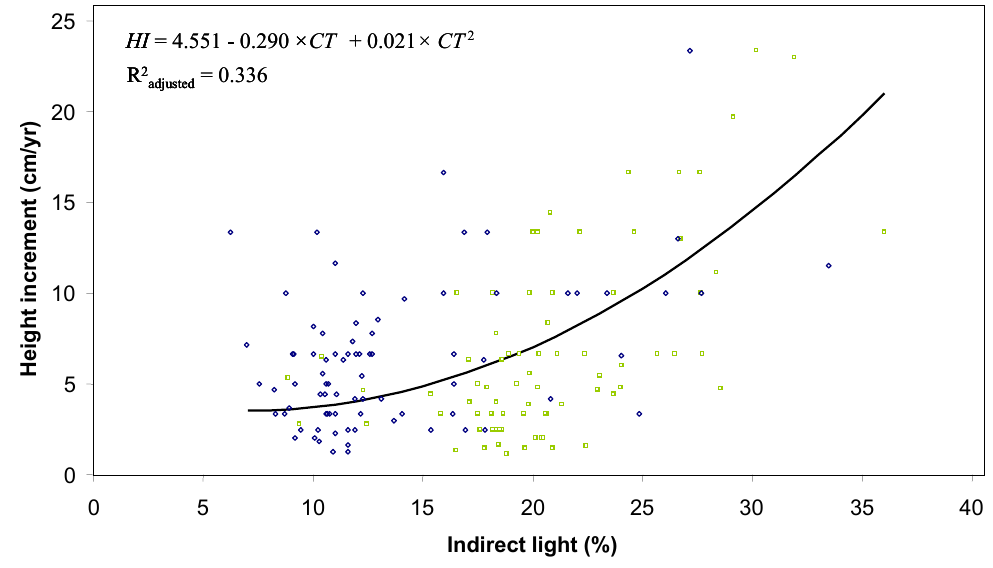
Figure 5. Relationship between height increment ( HI ) and canopy transmittance ( CT ) calculated from Equation (2) for northern white-cedar harvested stems of the Outaouais Region (OR site; green squares) and Papineau-Labelle wildlife reserve (PL site; blue diamonds); n = 144